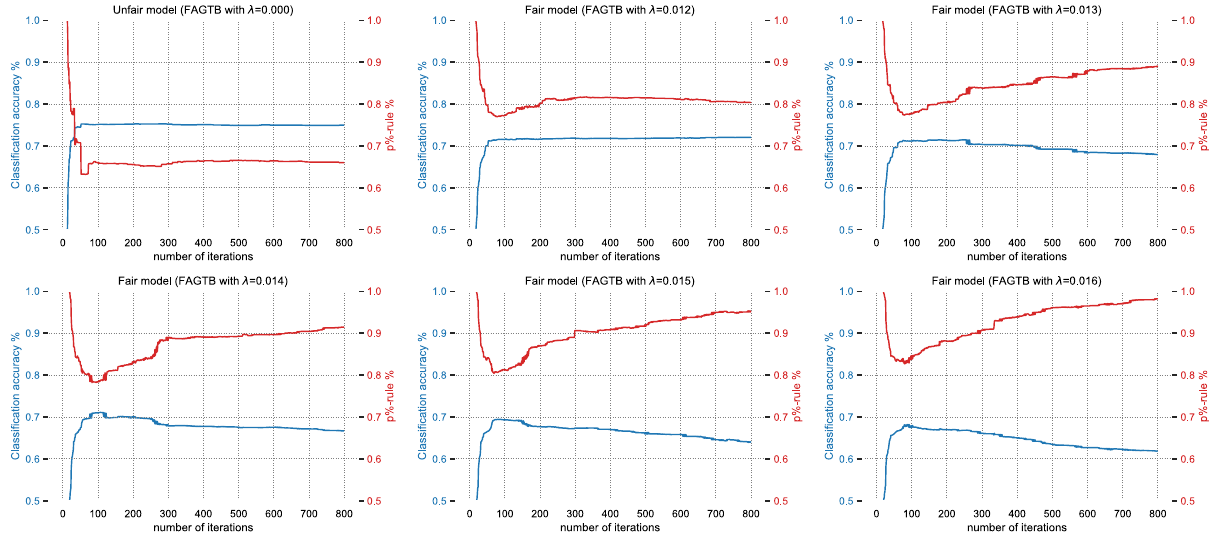
Fig. 2 Synthetic scenario: accuracy and p -rule metric for a biased model ( 𝜆 = 0 ) and for several fair models with varying values of 𝜆 optimized for demographic parity